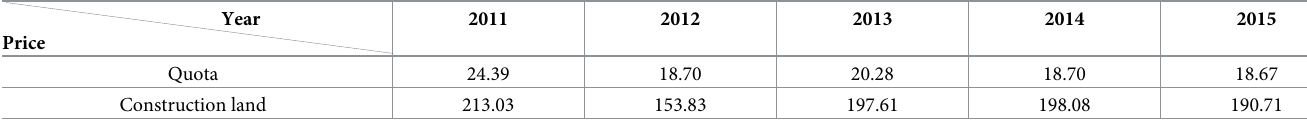
Table 1. Average price of the quota and construction land in Chongqing from 2011 to 2015 (ten thousand yuan /mu).